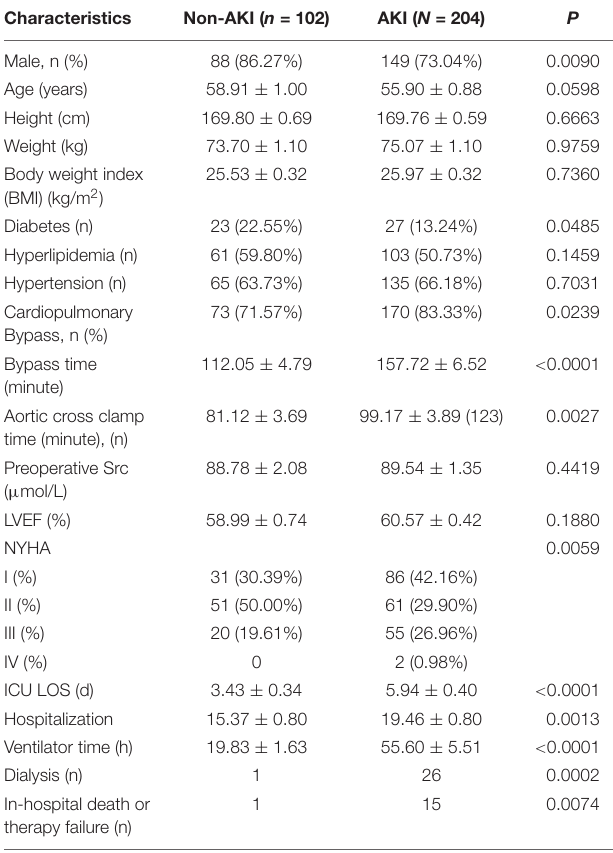
TABLE 1 | Baseline characteristics of patients with non-AKI and AKI ( N =